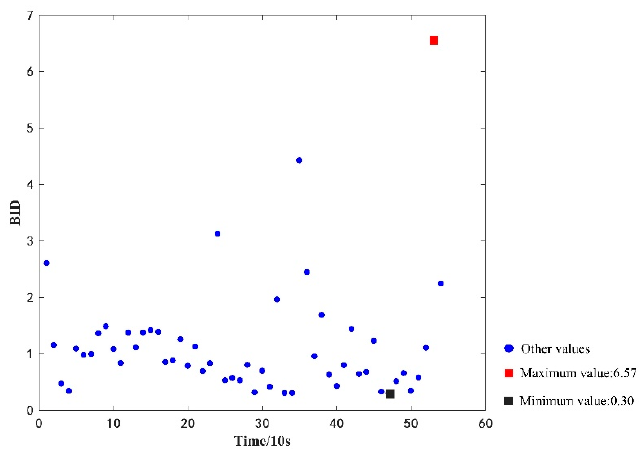
Figure 9. Bid values of the fault-free dataset.